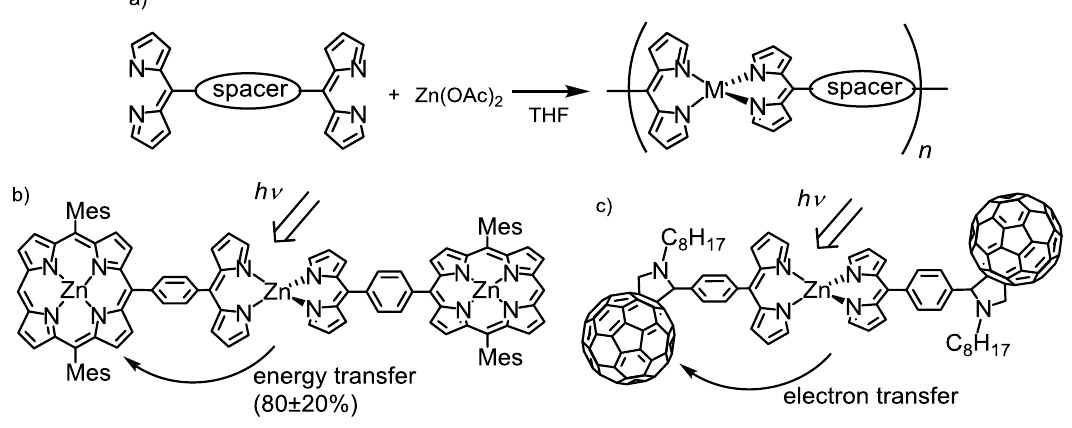
Figure 12. ( a ) Coordination polymer based on a dipyrrinato-metal complex. ( b , c ) Self-assembled donor-accepter systems that express either energy or electron